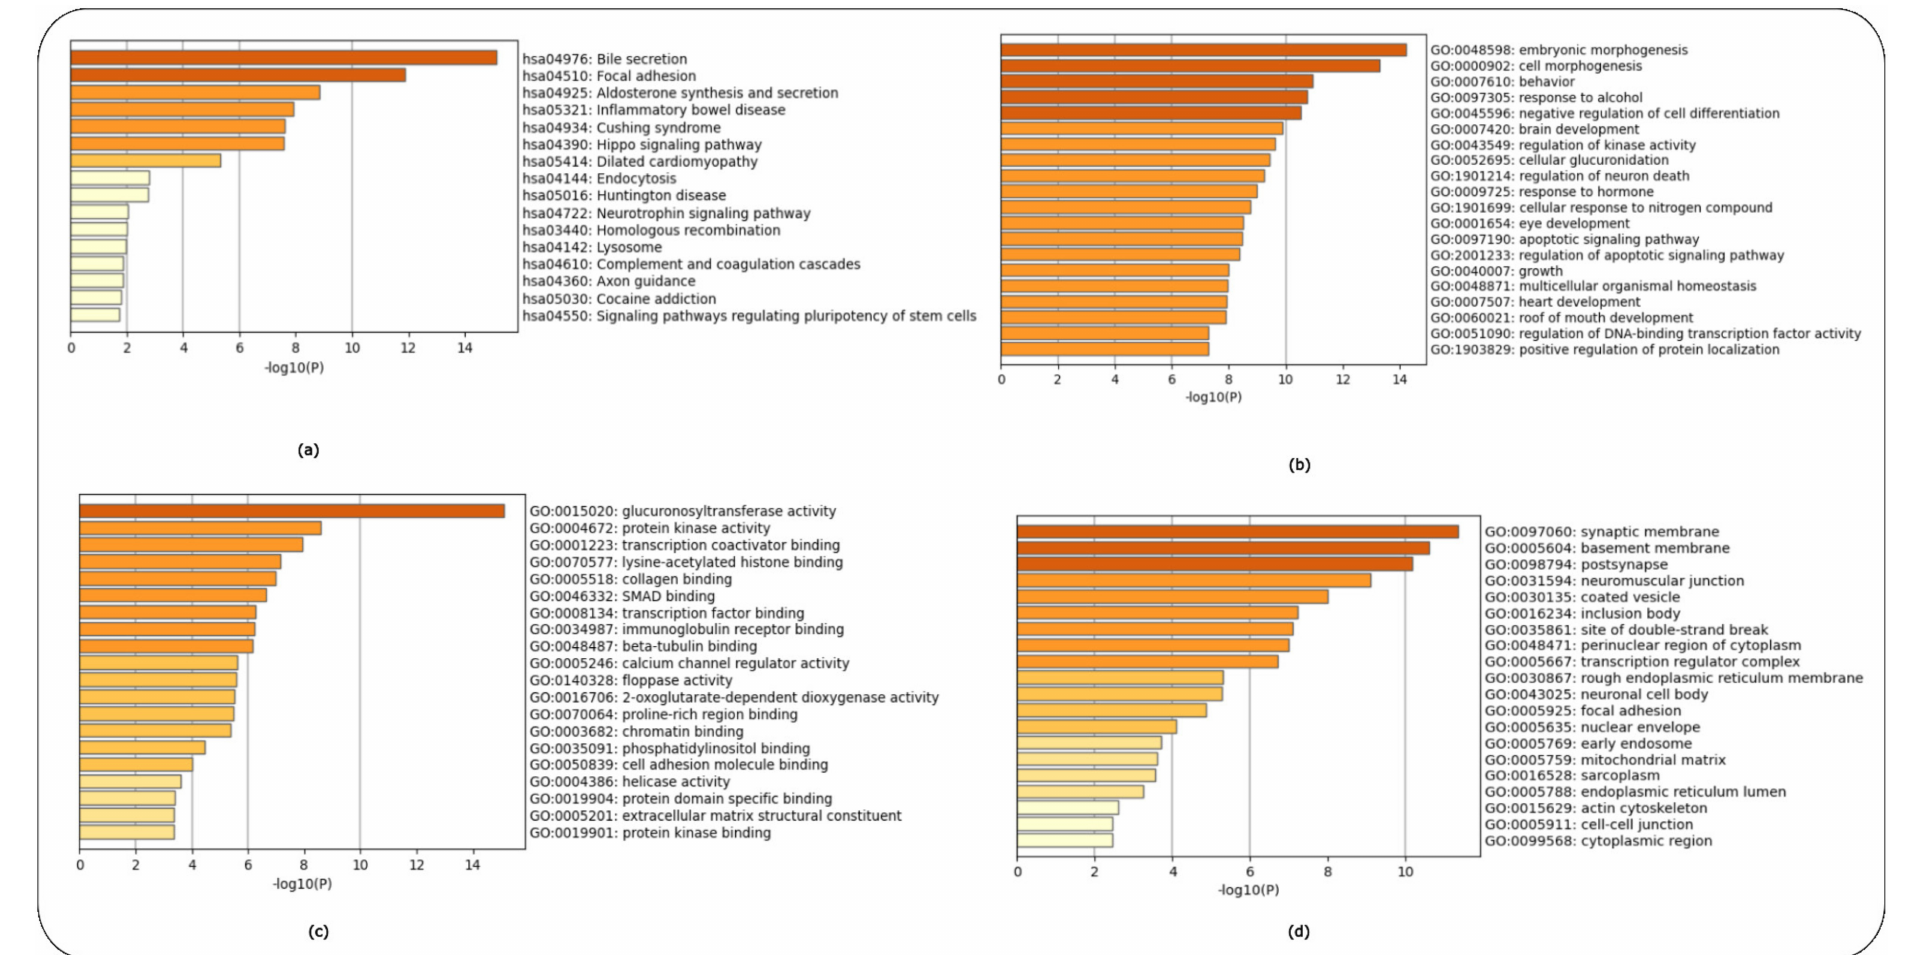
Figure 3. Enrichment analysis of controls versus pre-symptomatic HD patients using the KEGG and GO libraries in Metascape. ( a ) KEGG pathways, ( b ) GO Biological Process, ( c ) GO Molecular Function and ( d ) GO Cellular